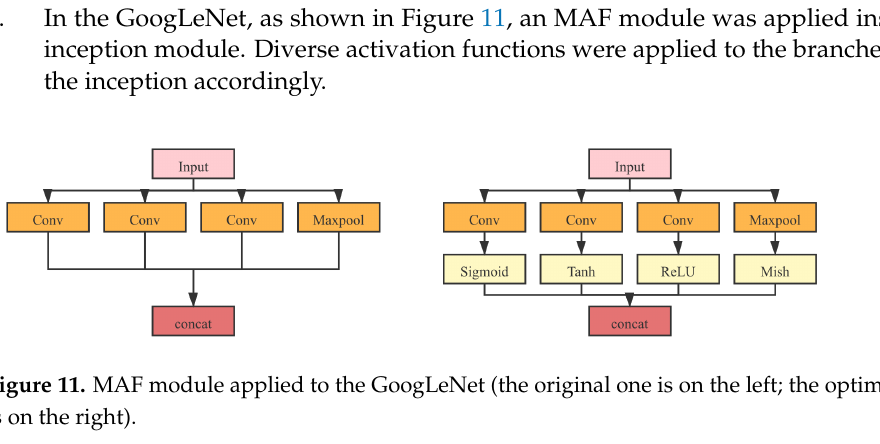
Figure 10. MAF module applied to the ResNet series (the original one is on the left; the optimized one is on the right).